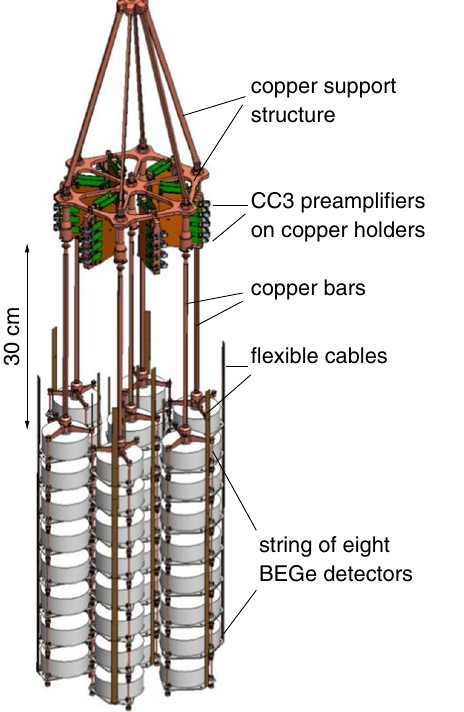
Fig. 7 Arrangement of the seven detector strings with preamplifiers